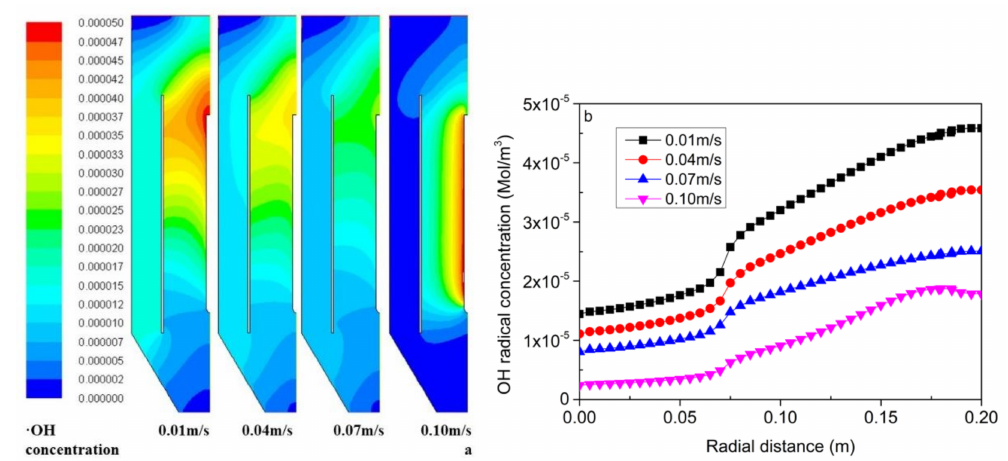
Figure 7. The contours ( a ) and the radial distribution ( b ) of molar concentration of · OH at di ff erent gas velocities in Section 2.